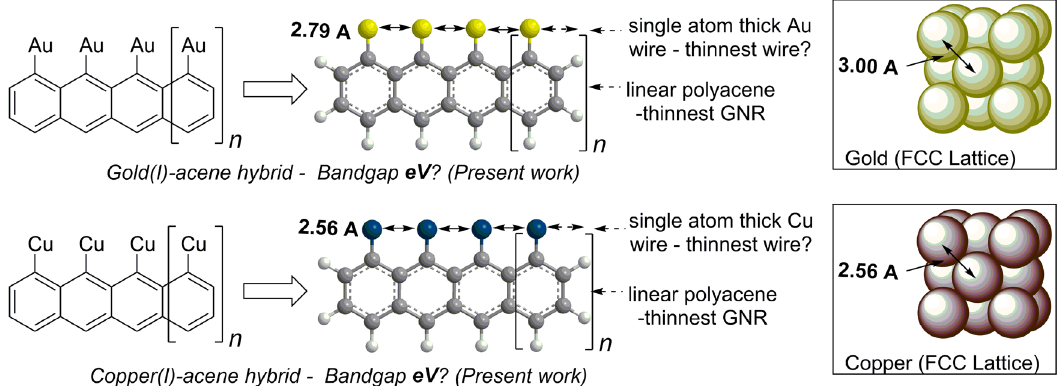
Fig. 1 This fi gure illustrates a proposed metal-polyacene hybrid semiconductor created through ionic BC-triggered cascade polymerization. It displays the thinnest linear polyacene covalently bonded to a single-atom-thick transition metal wire, with the distance between metal atoms similar to that of the face-centered cubic lattice of gold and copper